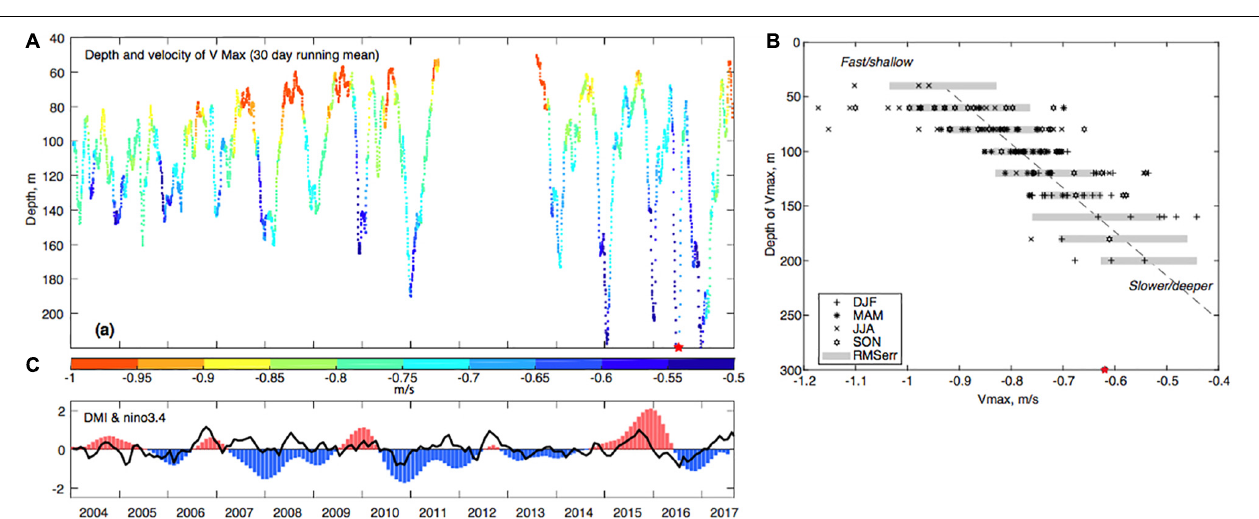
FIGURE 3 | (A) Time series of depth of the velocity maximum (Vmax) from the mooring within Labani Channel of Makassar Strait, color coded by speed (m/s). An anomalous deep Vmax occurred in June/July 2016, which is likely the imprint of a strong Kelvin Wave intrusion from the Indian Ocean. (B) The IOD (black line) and Nino3.4 Index (blue: la Niña; red: el Niño) over the same period as the mooring deployment. (C) Scatter plot of Depth of Vmax versus Vmax stratified by season (Figure from Gordon et al.,